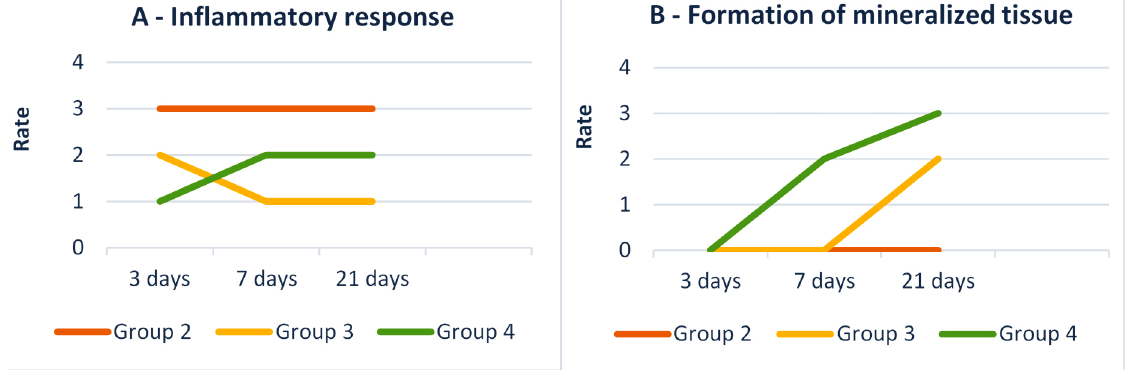
Figure 12- Results of histopathological assessment according to the modified version of ISO 10993 and 7405. The Y-axis corresponds to the rate of A – inflammatory response by observation of inflammatory infiltrate and disorganization of pulp tissue; and B – mineralized tissue formation by the observation of reparative dentin formation. The X-axis corresponds to the study